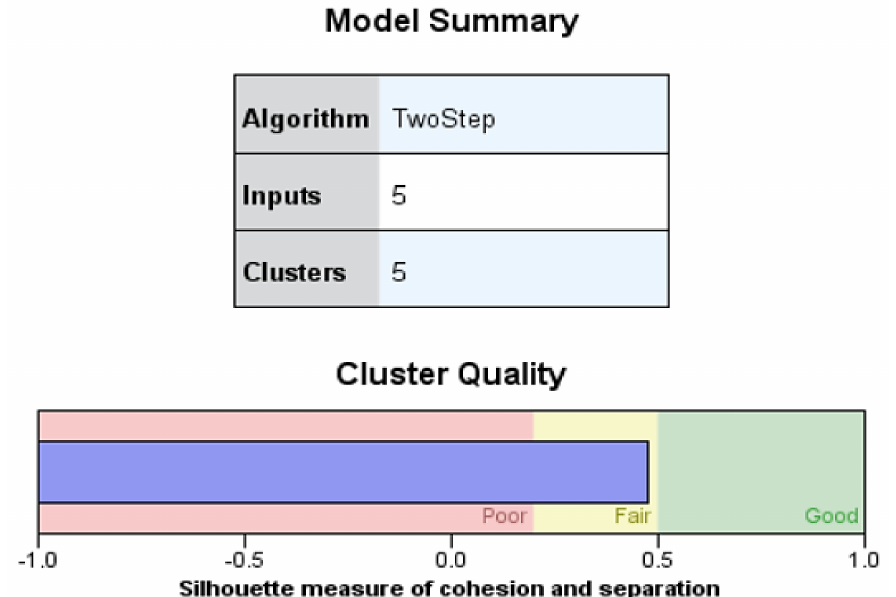
Figure 2. Model summary and cluster quality based on Silhouette’s measure of cohesion and